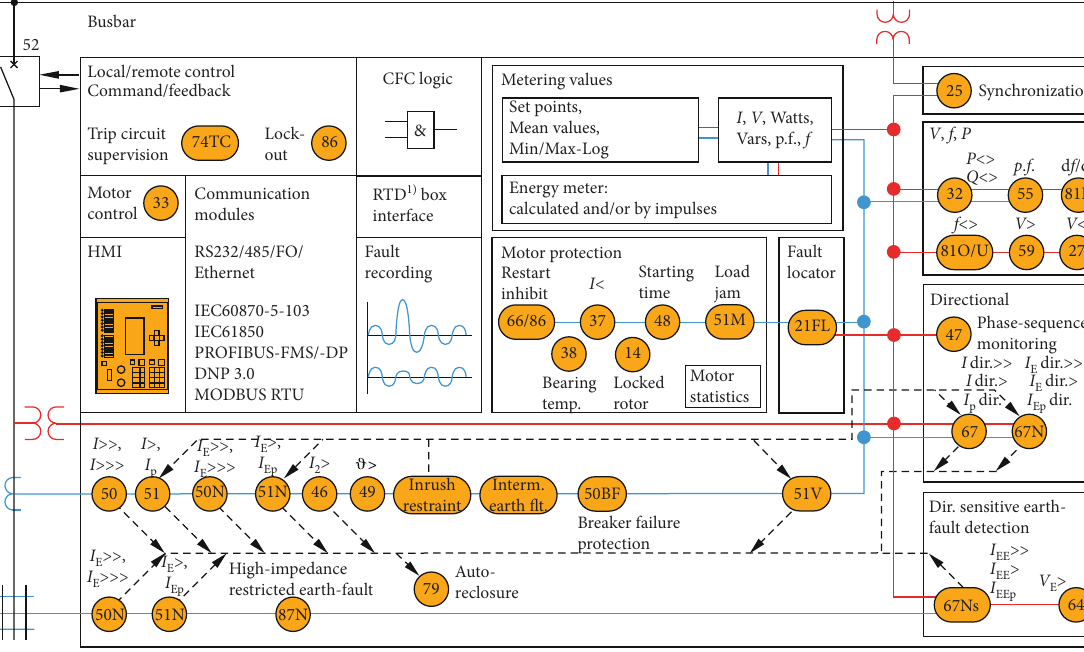
Figure 2: 7SJ64 relay function